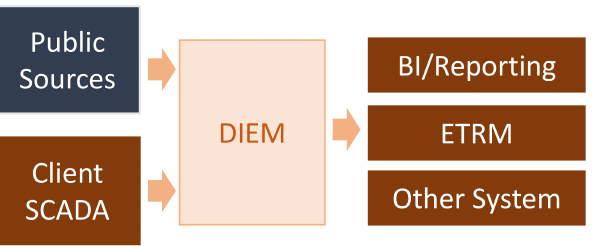
Figure 6. DIEM integrates with external systems for acquiring and sharing data.